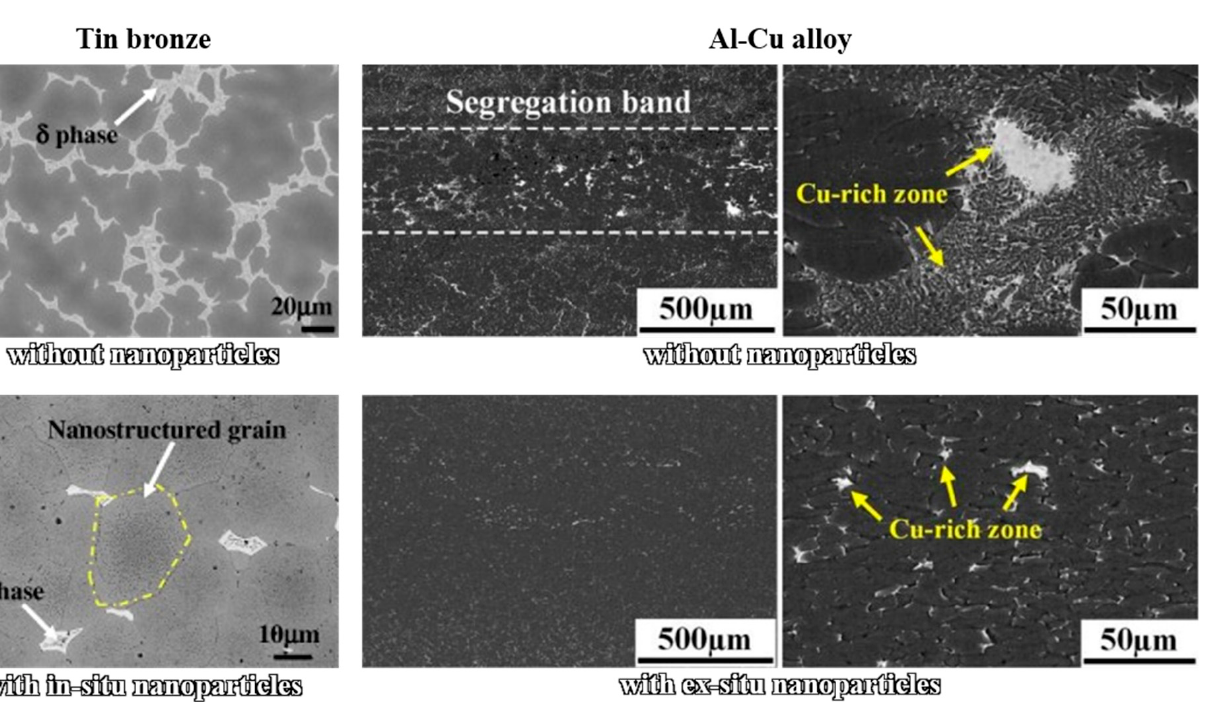
Figure 7. Microstructure refining mechanism by nanoparticles, reprinted with permission from ref. [116], 2022, Elsevier.